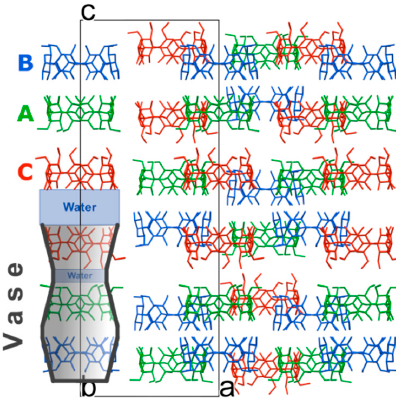
Figure 2. Crystal packing of α -CD molecules viewed along the b -axis. H atoms, disorder of α -CD C, SA and water molecules have been omitted for clarity. Symmetry-equivalent molecules are color coded.